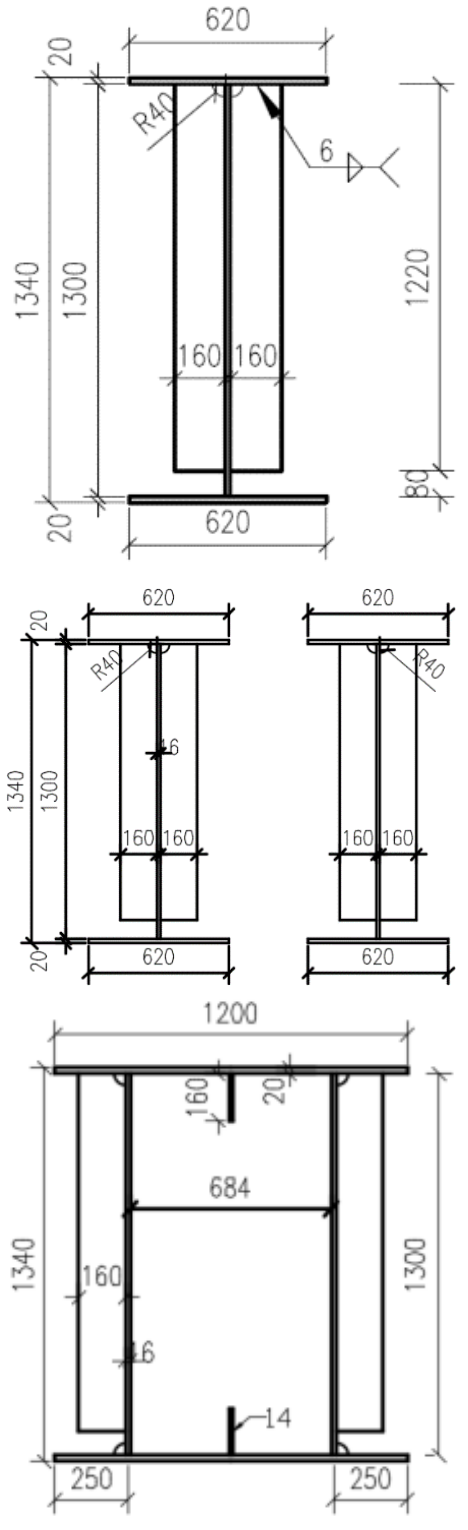
Fig. 7. The section form and size of longitudinal beam strengthened by bridge deck system